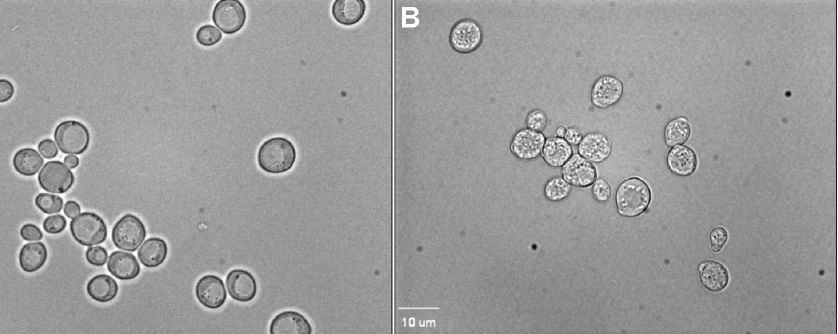
Figure 4. Phase contrast microscope images of FG08 effects on the cell internal structure of S.cerevisiae strain W303C. Cells were not treated (A) or treated (B) with FG08 (30 m g mL 2 1 ) for 10 min before visualization by phase contrast